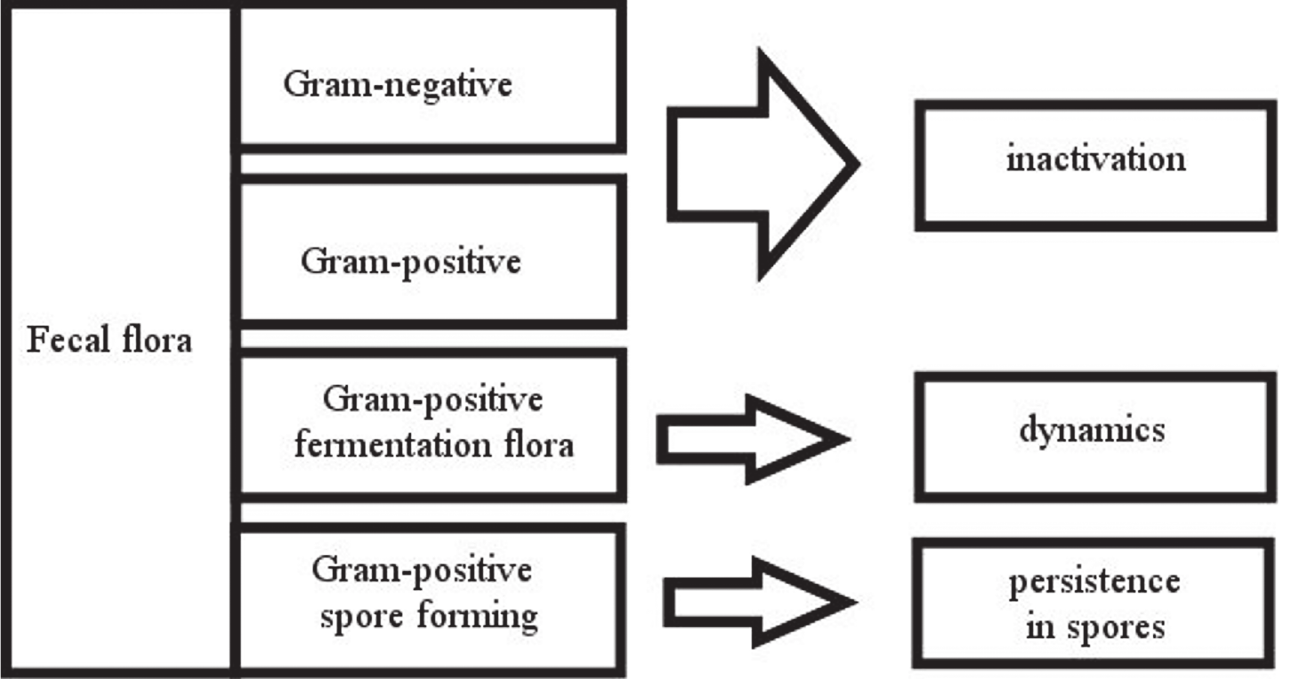
Fig 5. Flow chart of a typical community shift during